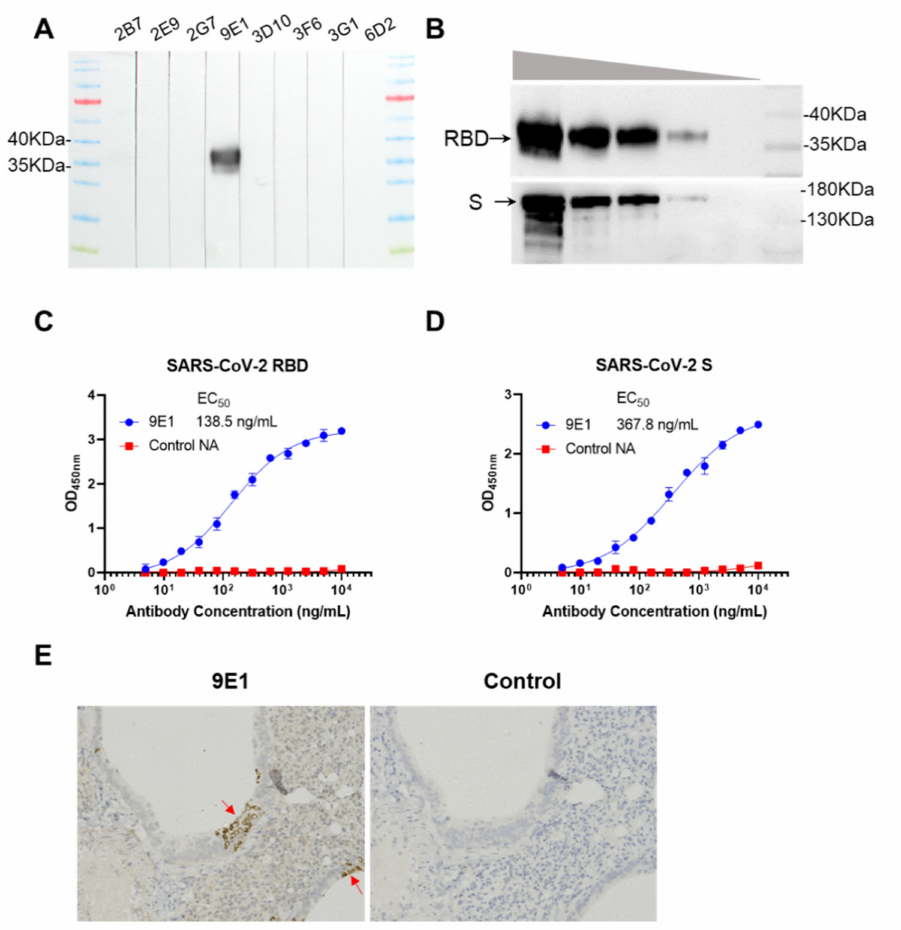
Figure 3. Reactivity of 9E1 with purified RBD and S protein. ( A ) Western blot reactivity of isolated rabbit antibodies with denatured RBD protein. ( B ) 9E1 was tested by Western blot for sensitivity against RBD (up) and S (down) proteins. From lane left to lane right, 2, 1, 0.5, 0.1, 0.01 µ g protein was loaded separately. ( C , D ) Purified 9E1 were diluted from 10 µ g/mL to 5 ng/mL to measure the reactivity with RBD and S protein in ELISA assay. ( E ) The detection of SARS-CoV-2 in the lung tissue of infected hamster. Hamster was infected by SARS-CoV-2 with 10ˆ4 PFU and euthanized 3 days later. Lung of the hamster was collected and tested by immunohistochemistry. 9E1 was used as primary antibody with dilution rate